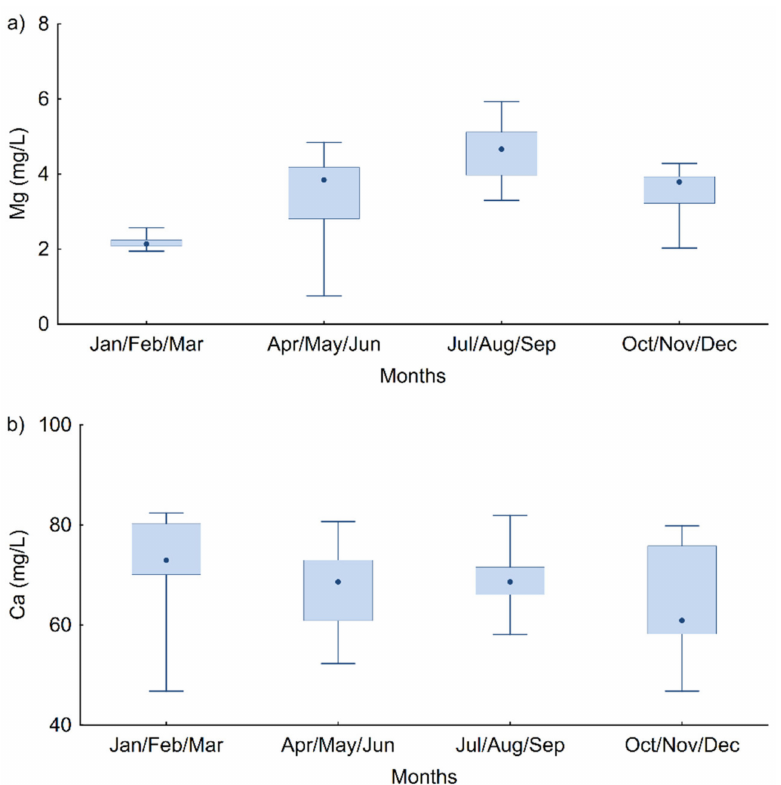
Figure 2. Median values and ranges of concentrations of ( a ) Mg and ( b ) Ca ion, in all water samples in each quarter of the